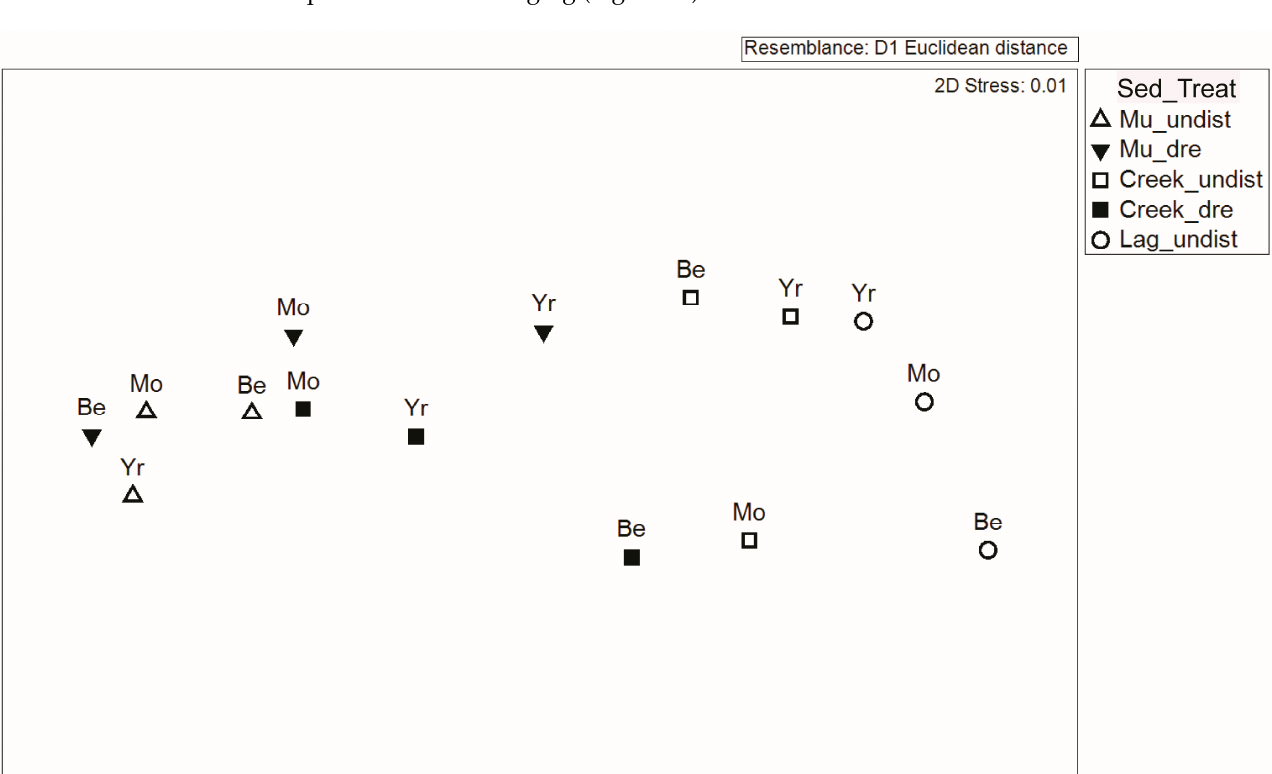
Figure 2. Non-metric multidimensional scaling based on mean values for characteristics of sediments. Mu_undist = muck that was not dredged, Mu_dre = muck that was dredged, Creek_undist = sediments in creeks that were not dredged, Creek-dre = sediments in creeks that were dredged, Lag_undist = sediments in the lagoon that were not dredged, Be = before dredging, Mo = one month after dredging, Yr = one year after dredging.